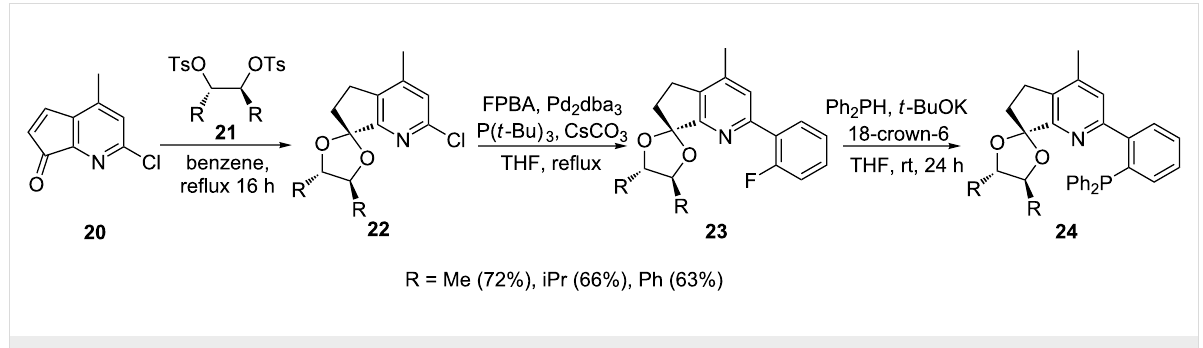
Scheme 4: Synthesis of chiral acetal pyridylphosphine